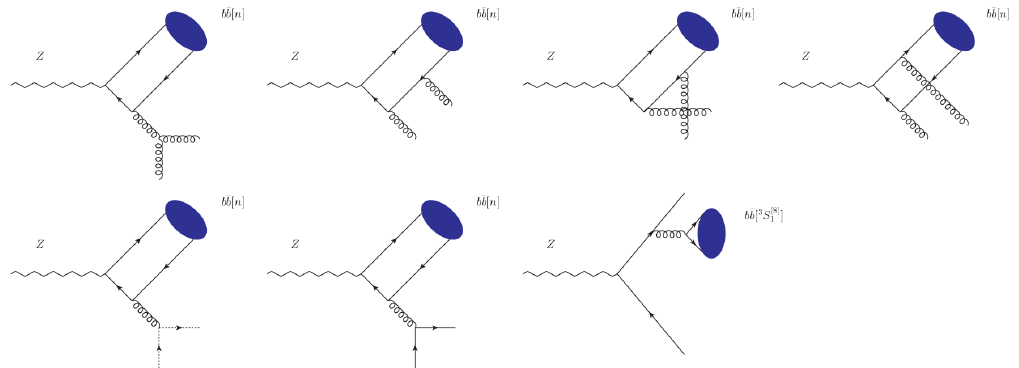
Figure 2 . Typical diagrams for the real corrections to Z → b ¯ b [ n ] + g . n = 1 S [8]